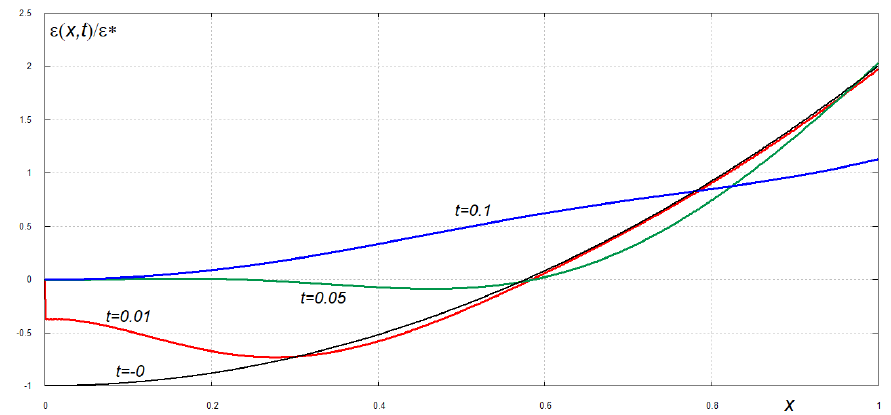
Figure 9. Scaled strain distributions for small times after the plate breaking.